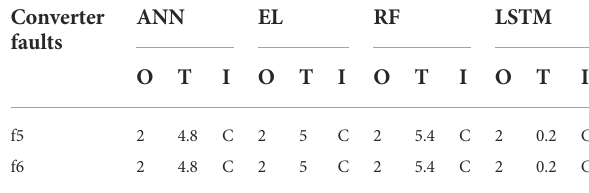
TABLE9Performanceresultsofthebackuprelayduringtheconverter fault. Converter